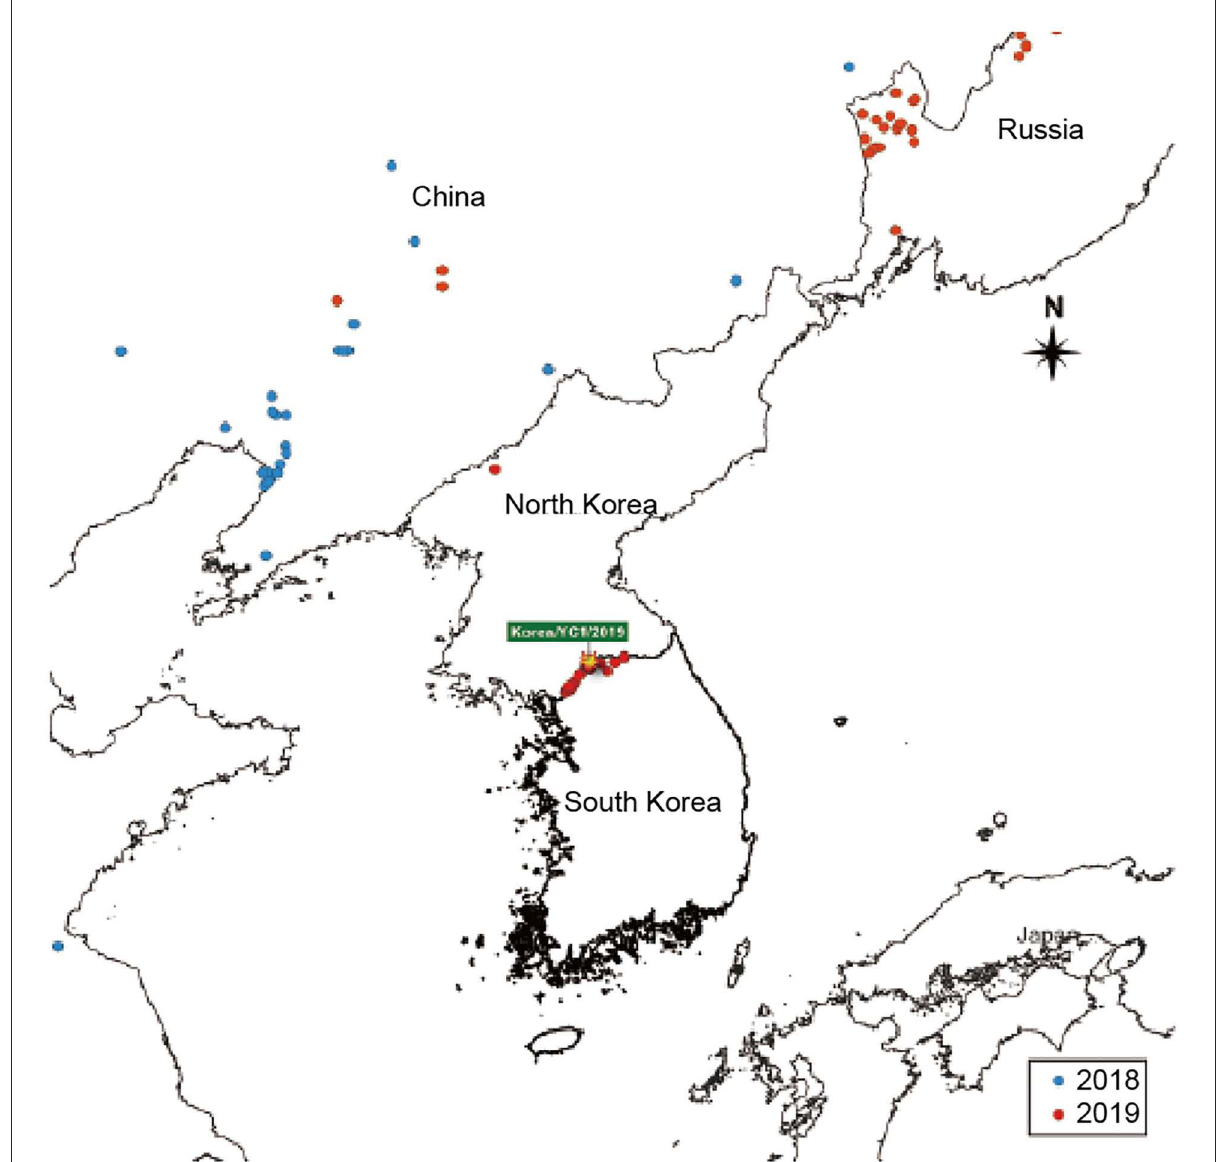
FIGURE1 ASF-affected areas are represented. South Korea is indicated on the map. The outbreaks in 2018 and 2019 are indicated with blue and red dots,